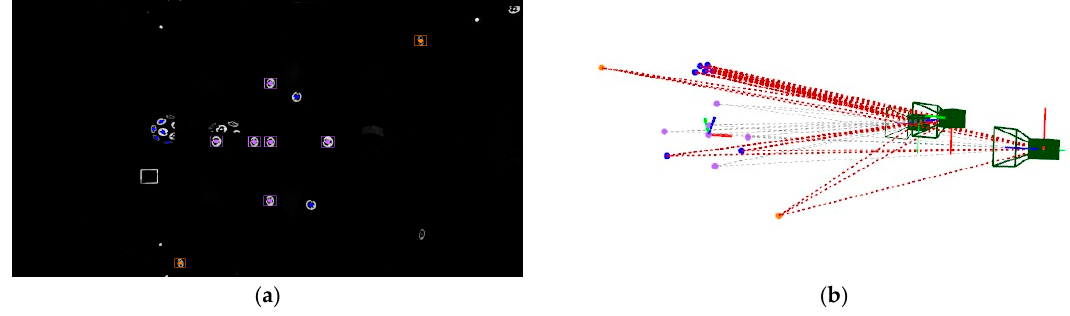
Figure 9. Example of target detection ( a ) in image 3 (Figure 8c), including coded targets (blue) and non-coded targets with solved correspondences (red), along with targets on the measuring reference frame (purple). 3D view of the scene ( b ) including the epipolar net (red) for solving the detected 3D target coordinates (blue and red) given by the three images in Figure 8.